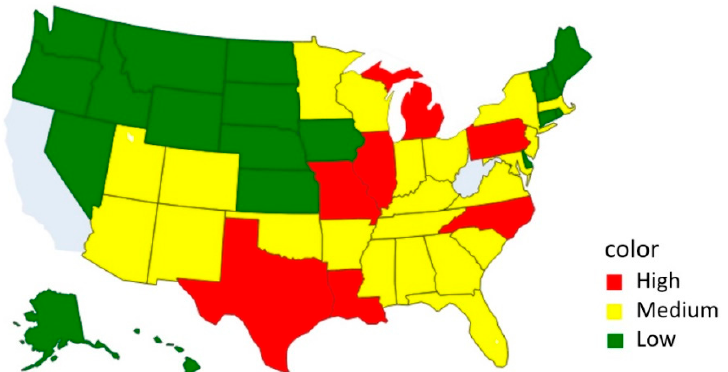
Figure 5. Clustering results from Cascade K-means.